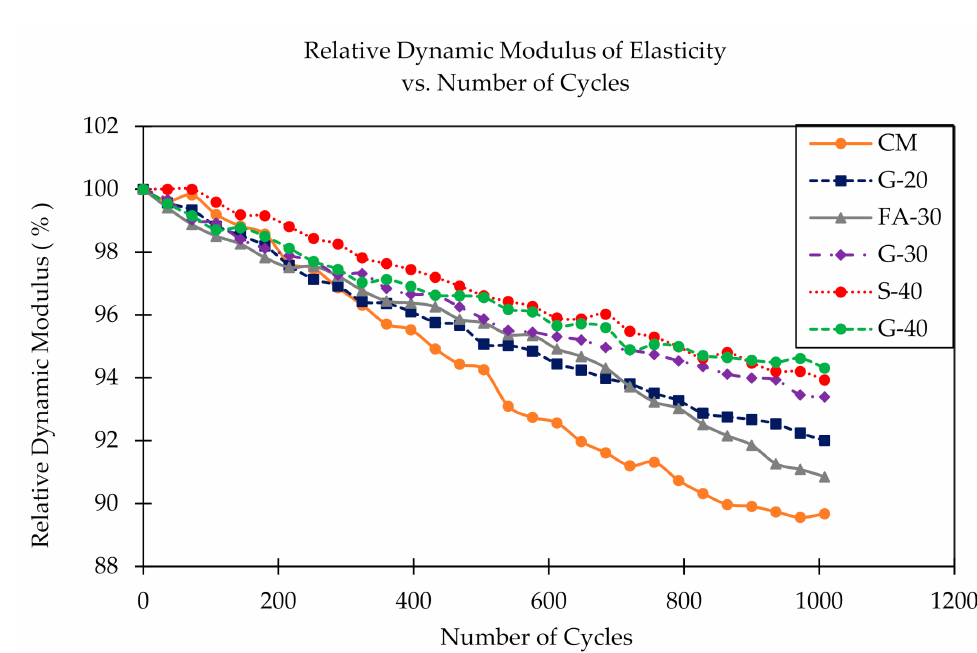
Figure 10. Visual observation of scaling and deterioration.